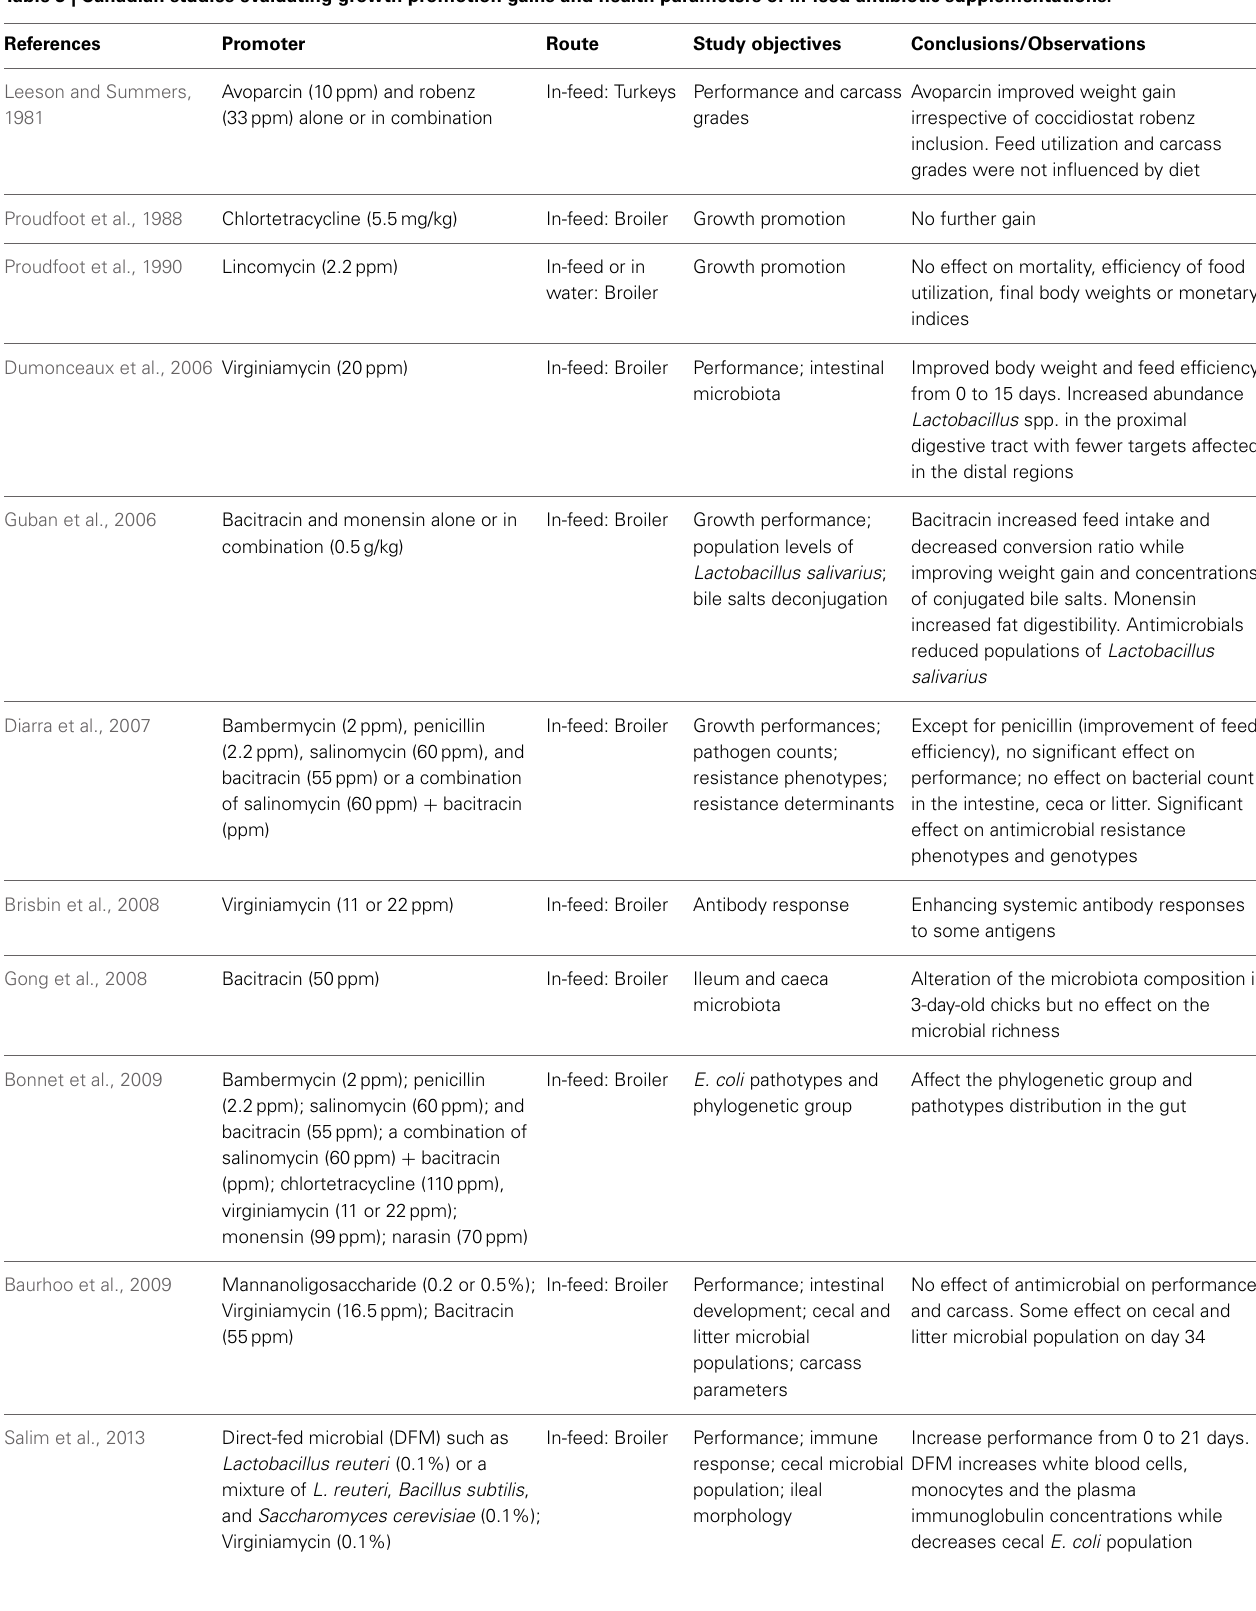
Table 3 | Canadian studies evaluating growth promotion gains and health parameters of in-feed antibiotic